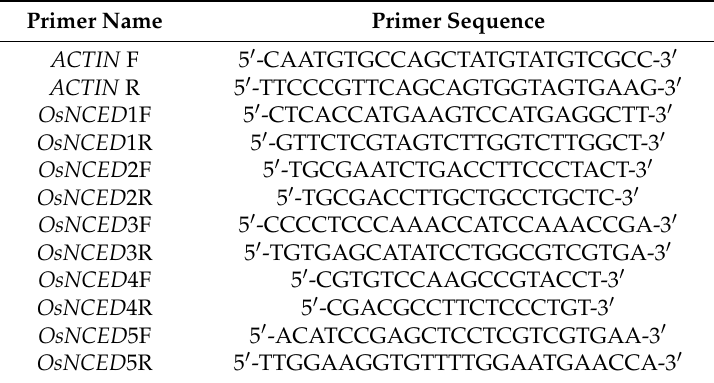
Table 1. OsNCED genes